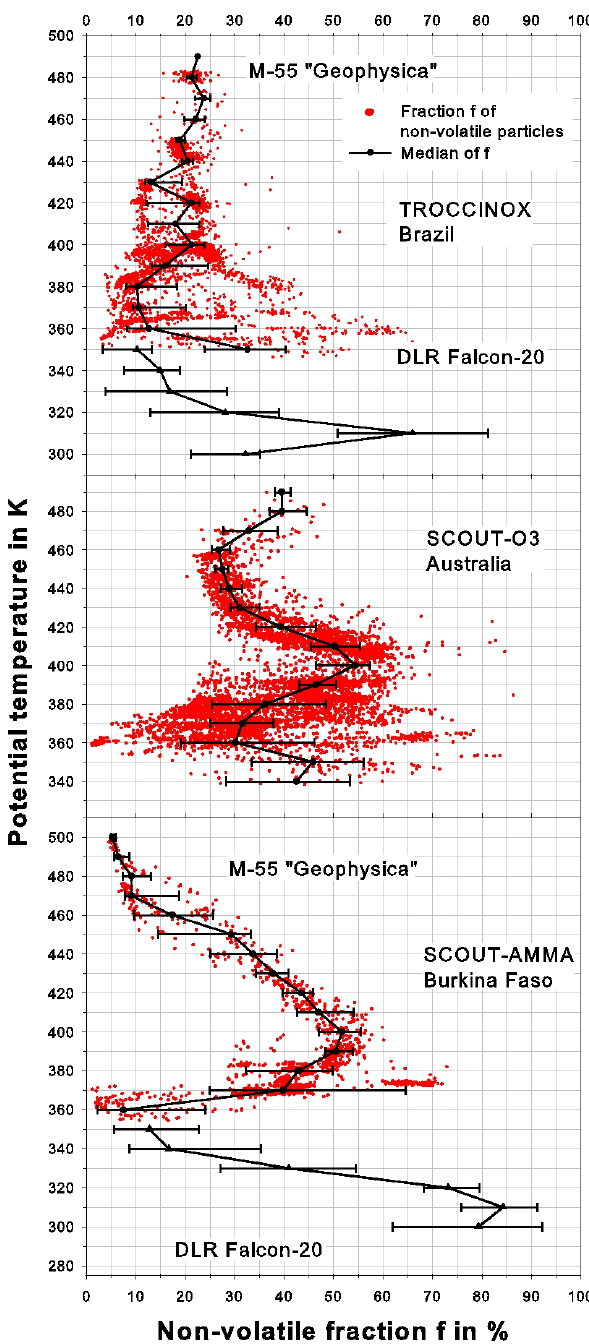
Fig. 11. Ratio f of non-volatile particle number concentration N 10nv to total ambient particle number density N 10 as function of altitude (points: 15s flight time averages; Symbols: medians, 25% and 75% percentiles of 10K bins). The data are from the lo- cal flights over Arac¸atuba (Brazil, 2005), Darwin (Australia, 2005), West Africa (red points and line above 360K). Similarly, thermod- enuder measurements of N 7 from the DLR Falcon-20 are included (without individual data points) where available for potential tem- perature levels below